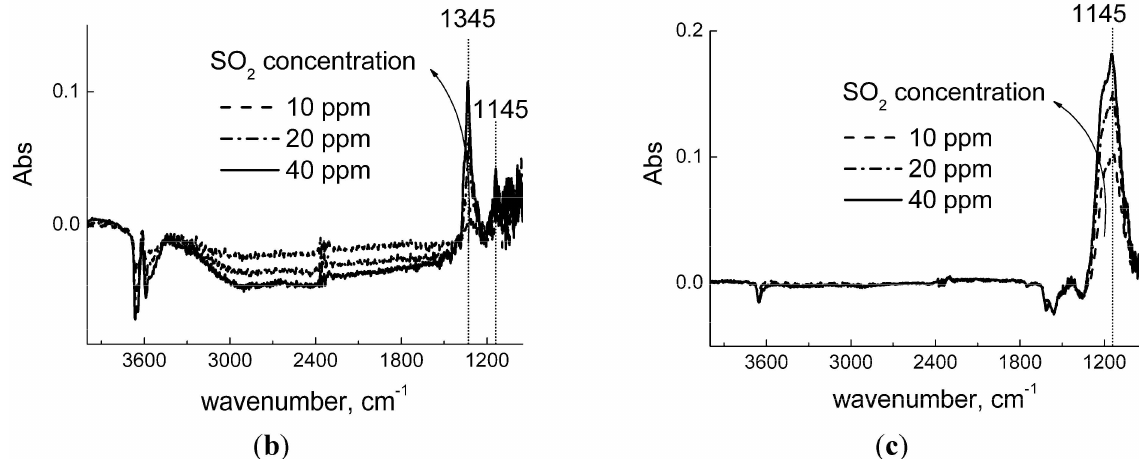
Figure 8. DRIFT spectra of SnO at room temperature ( a ) DRIFT spectra of SnO exposed to increasing concentration of SO